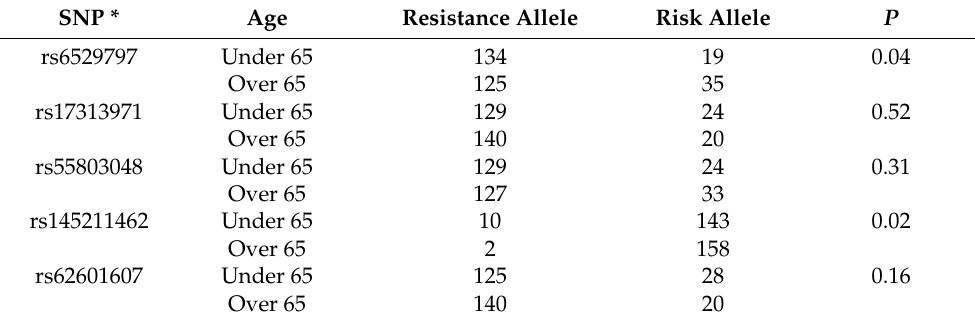
Table 4. Genotype of peak SNPs by